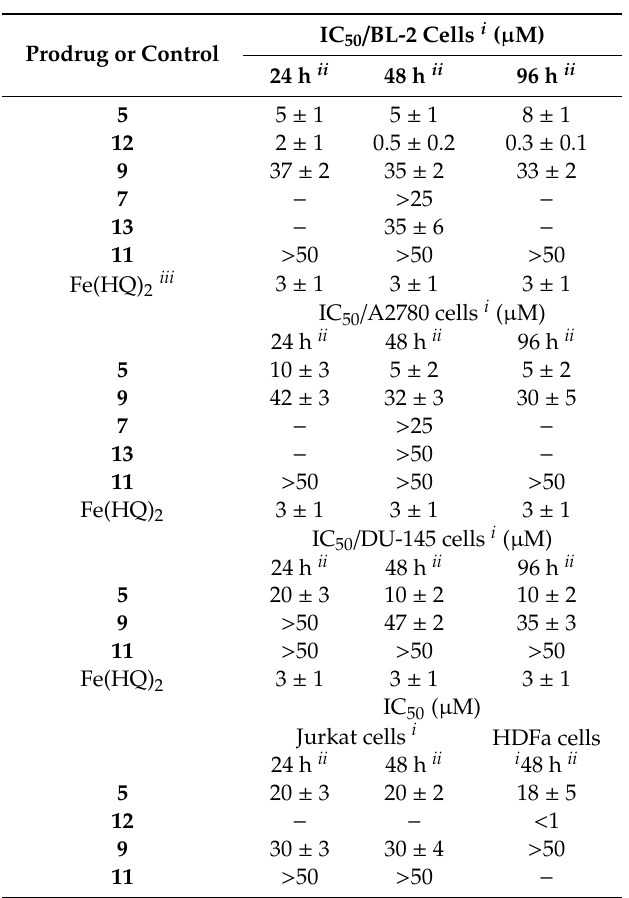
Table 1. E ff ects of prodrugs and control compounds on the viability of selected cancer and normal cells lines expressed as half-maximal inhibitory concentration (IC 50 , µ